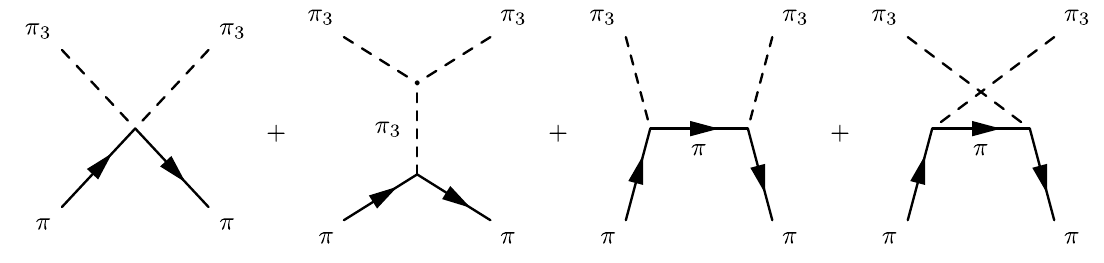
Figure 2 . Diagrams contributing to π 3 π → π 3 π at